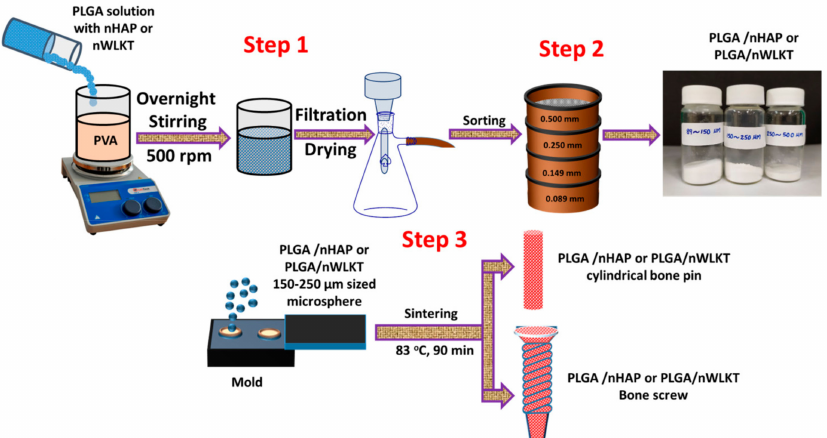
Figure 1. The schematic representation of poly (lactic-co-glycolic acid) (PLGA) / nHAP or PLGA / nWLKT microsphere preparation (step 1, 2) and the subsequent fabrication process of microsphere sca ff old by using surface sintering (step